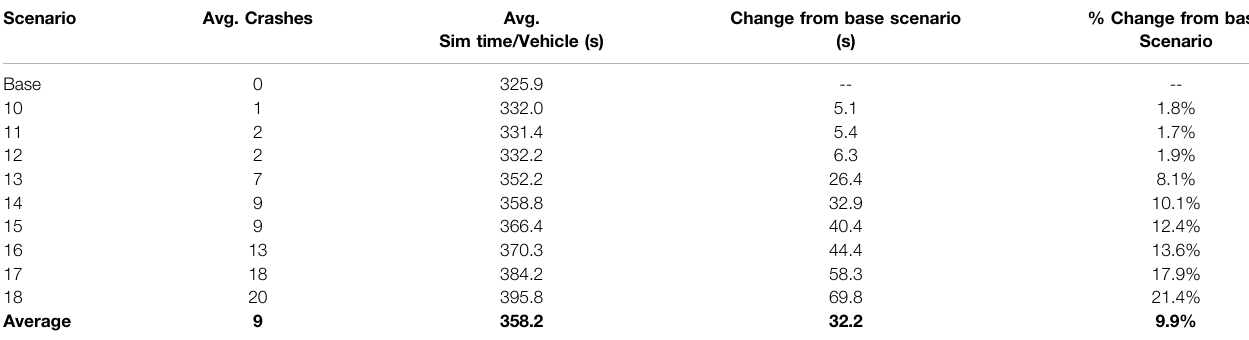
TABLE 6 | MITM attack scenarios - relative travel time delay. Scenario